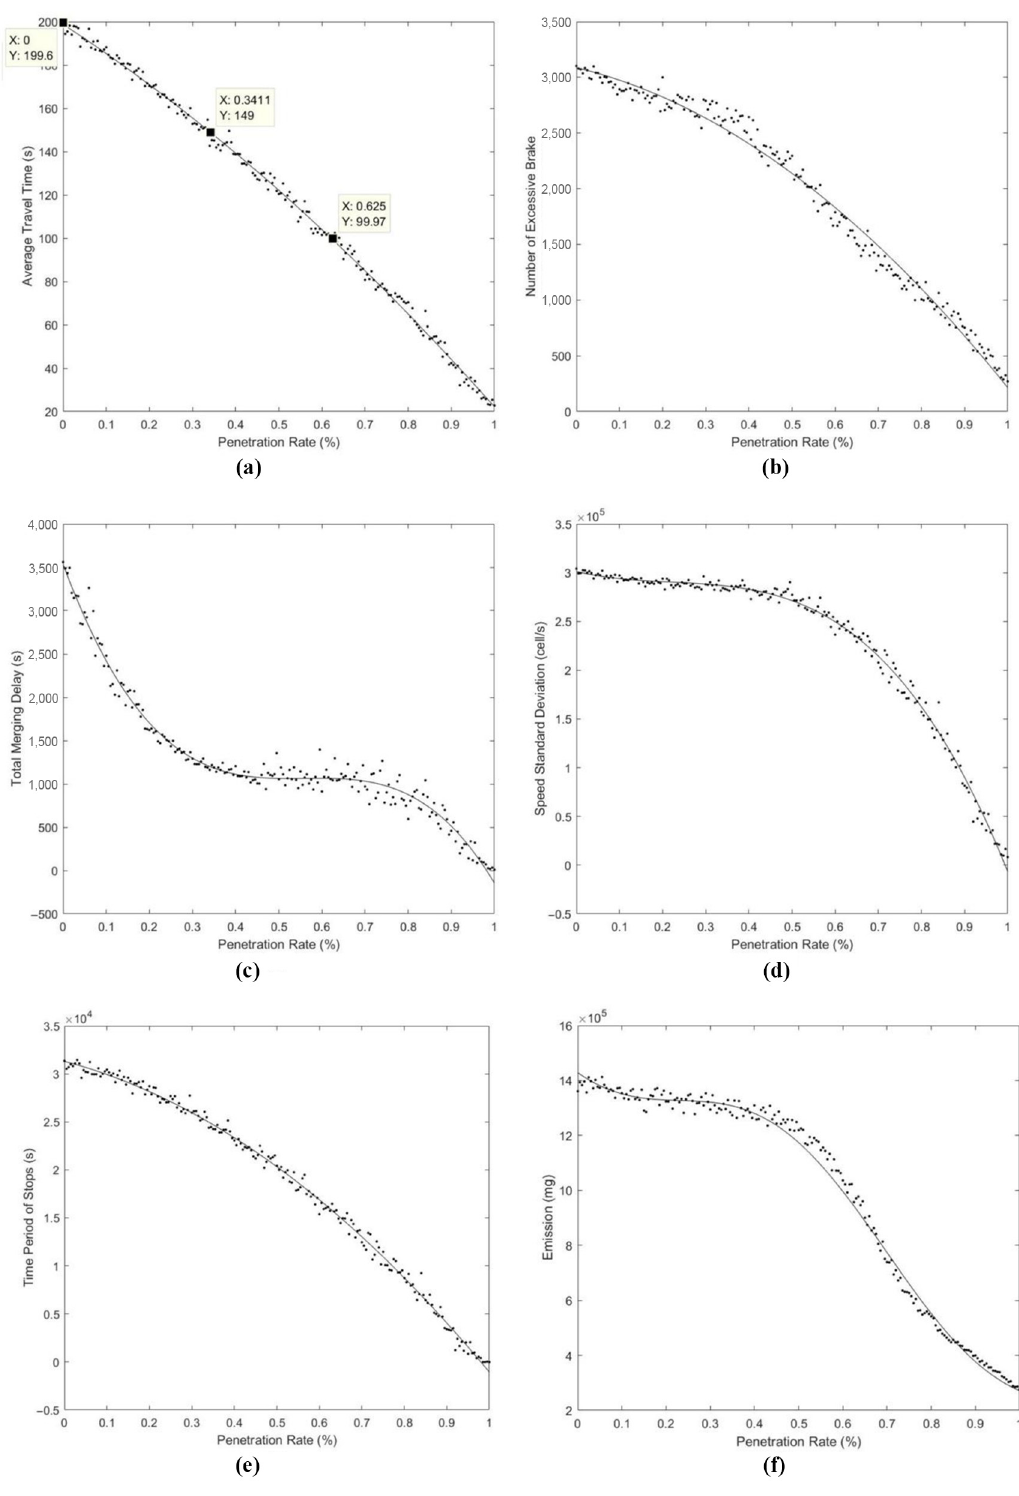
Figure 2 Deterministic indicators over penetration